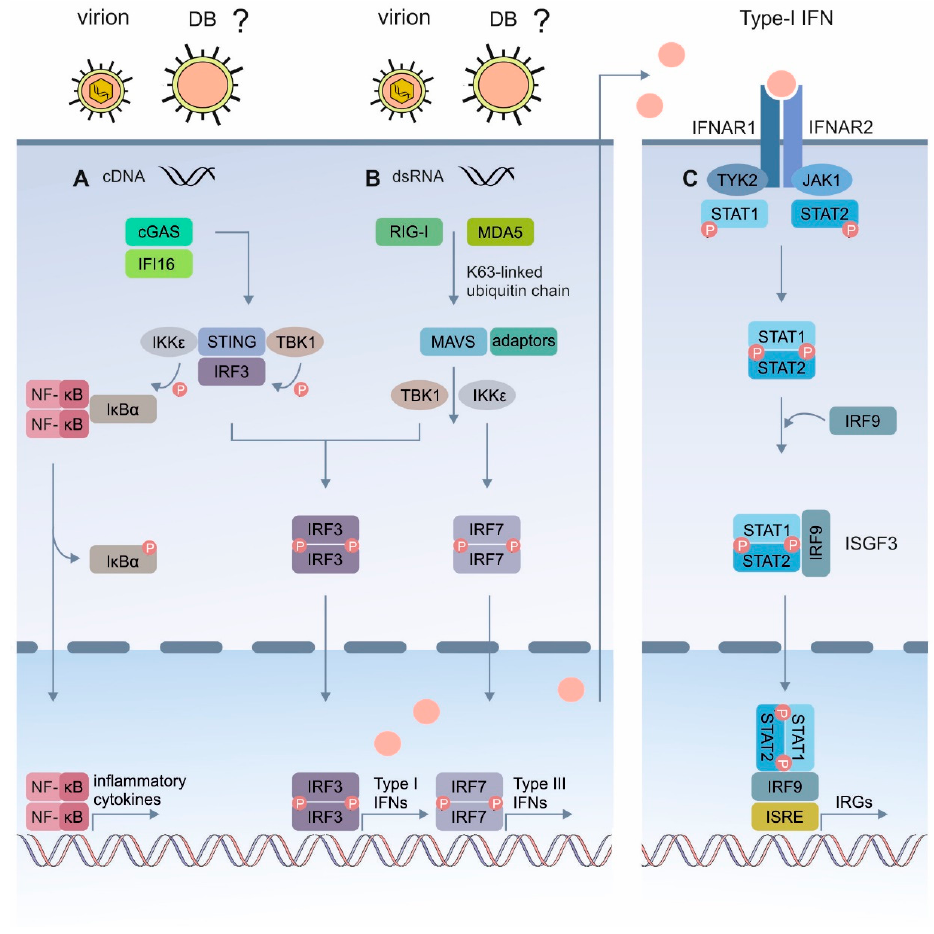
Figure 1. Schematic representation of the IRG induction following the cytosolic sensing of the virus infection. ( A ) Mechanism of the cytosolic DNA-mediated type-I IFN induction. Cytosolic (virus)- DNA is sensed by the cytosolic DNA sensors, such as IFI16 or cGAS. This triggers the STING-TBK1- IRF3 or IKKs- NF- κ B signaling cascades. Upon activation, the STING translocates from the ER to the Golgi, where it recruits the kinases TBK1 and IKK, leading to the phosphorylation of IRF3 and I κ B α , respectively. Phosphorylated IRF3 dimerizes, translocates to the nucleus, and activates the transcription of the type-I IFN genes. The phosphorylation of I κ B α leads to its dissociation from the complex and the translocation of NF- κ B to the nucleus, where it activates the transcription of the genes encoding the IFNs and proinflammatory cytokines. ( B ) The RLR signaling pathway. RIG-I or MDA5 are activated by cytosolic (virus)- RNA and interact with MAVS. MAVS becomes associated with several adaptor proteins that lead to the activation of the cytosolic kinases TBK1 and IKK ε . Phosphorylation of the transcription factors IRF3 and IRF7 leads to their translocation into the nucleus and the production of type I or type III IFNs. ( C ) Type-I IFN signaling through the JAK/STAT pathway. Binding of type-I IFNs to the heterodimeric receptor IFNAR, which comprises IFNAR1 and IFNAR2, results in the autophosphorylation and activation of the kinases JAK1 and TYK2, which phosphorylate STAT1 and STAT2. The phosphorylated STATs dimerize and associate with IRF9 to form the transcriptional activator complex ISGF3. ISGF3 translocates to the nucleus where it binds to the IRSE element and activates the transcription of the IRGs. DNA, cytosolic DNA; dsRNA, double stranded RNA; RIG-I, retinoic acid-inducible gene; MDA5, melanoma differentiation associated protein 5; MAVS, mitochondrial antiviral signaling protein; IFI16, IFN-inducible protein 16; cGAS, cyclic GMP/AMP synthase; I κ B α , inhibitor of the nuclear factor kappa B; IFNAR, interferon- α / β receptor; IKK, inhibitory kappa B kinase; IRF3, interferon regulatory factor 3; IRSE, IFN-stimulated response element; JAK1, Janus kinase 1; NF- κ B nuclear factor κ appa B; STAT1/2, signal transducer and activator of transcription 1/2; STING, stimulator of interferon genes; TBK1, TANK- binding kinase 1; TYK2, tyrosine kinase